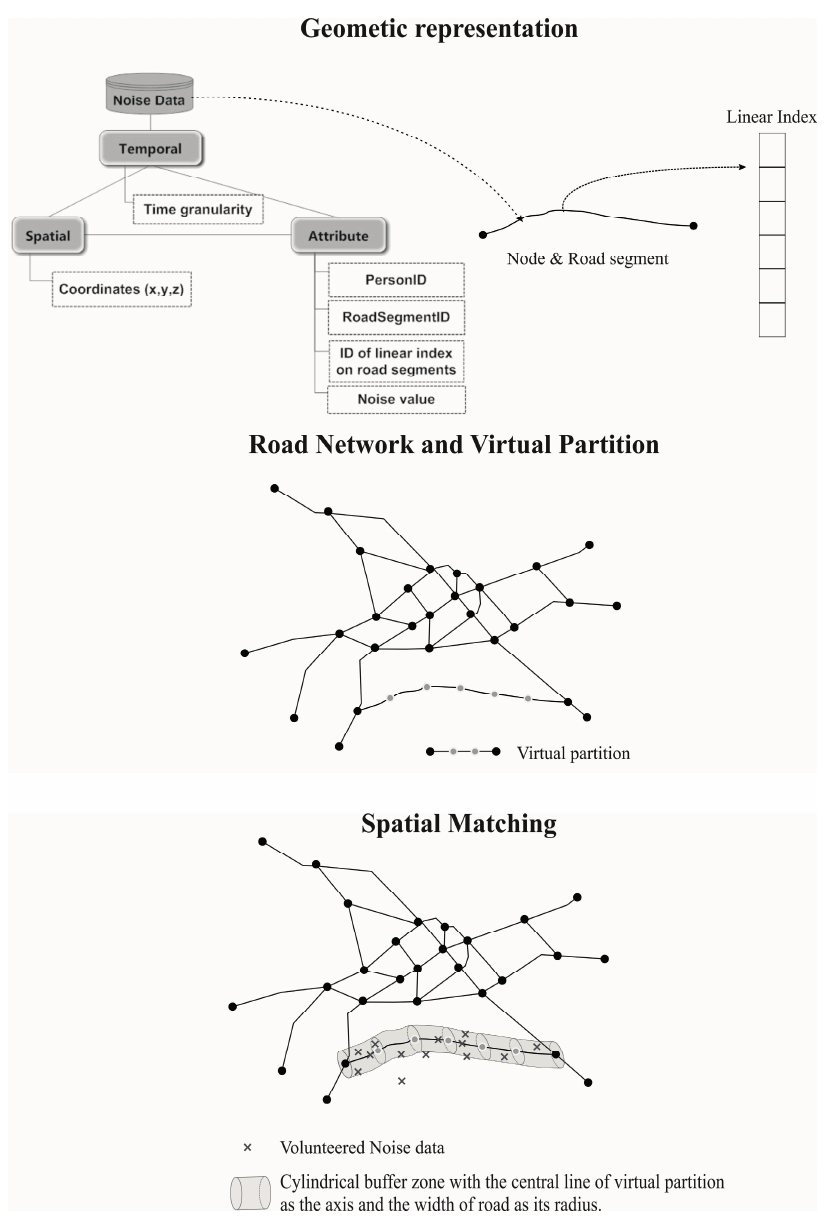
Figure 2. Spatial positioning components: geometric representation, semantic road networks, and spatial